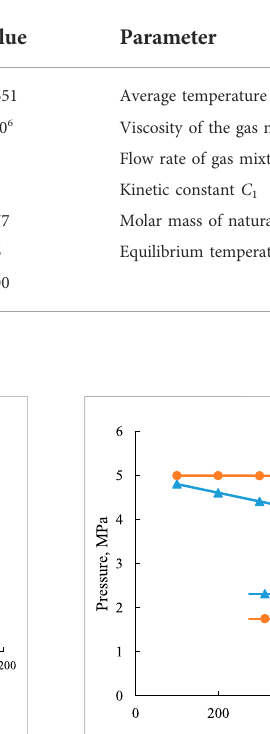
FIGURE 3 Pressure along the pipeline during 5 years of natural gas transport. FIGURE 4